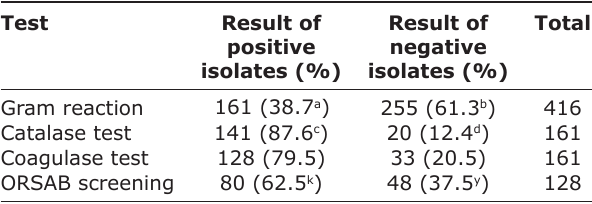
Table-1: Gram-staining, biochemical test and ORSAB screening of S. aureus isolates in hunting dogs in Maiduguri metropolitan, Borno